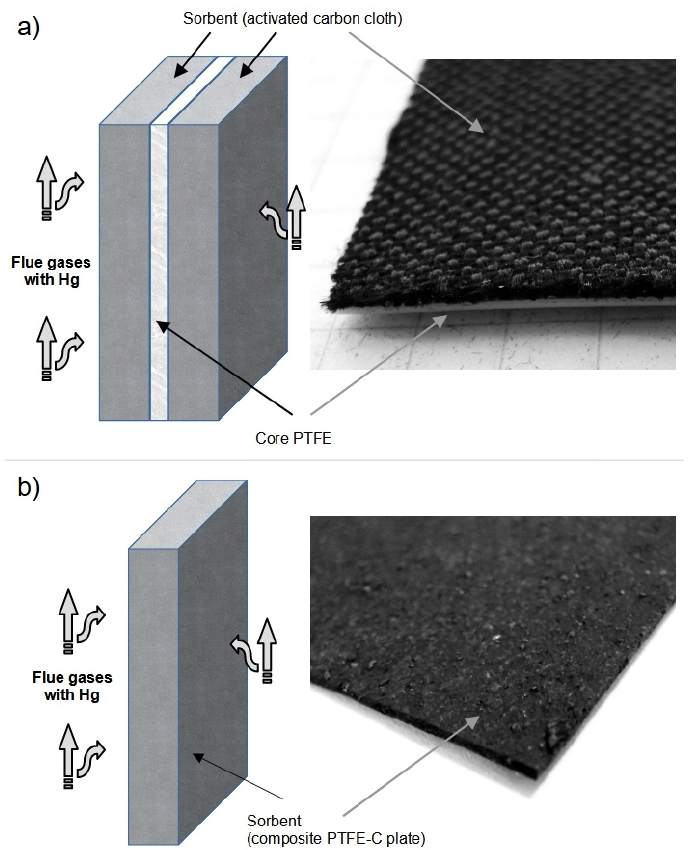
Figure 1. Two types of materials: FSM—layered sandwich ( a ), SPC—composite (PTFE-C) plate ( b ) .